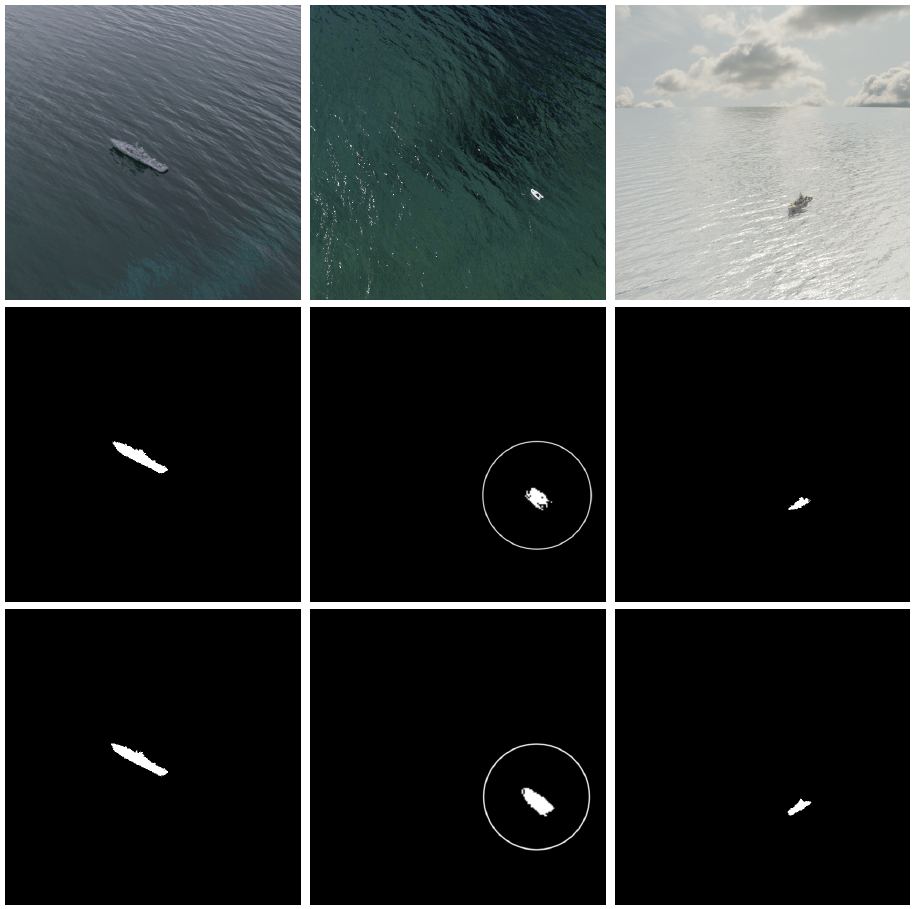
Figure 10. Qualitative evaluation on the MarSyn detection dataset. Top row: original images; middle row: Yolact++ segmented images; bottom row: final segmentation result after post-processing with 3D CRF. Circles in the second column denote a magnified image for better